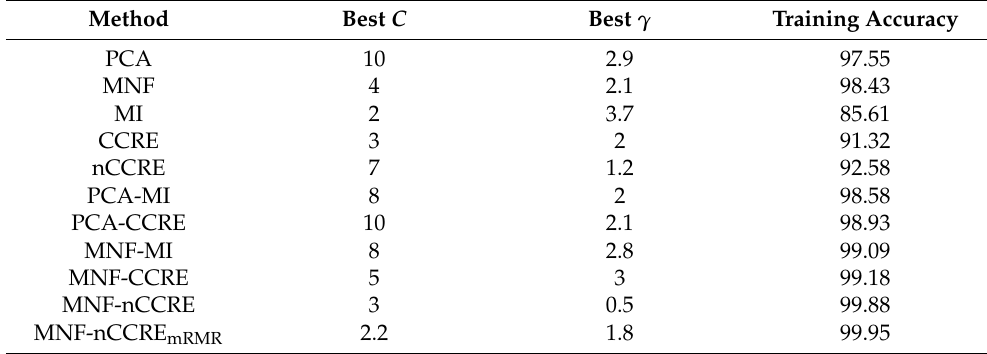
Table 7. Parameter tuning results using tenfold cross-validation for the HYDICE WDM